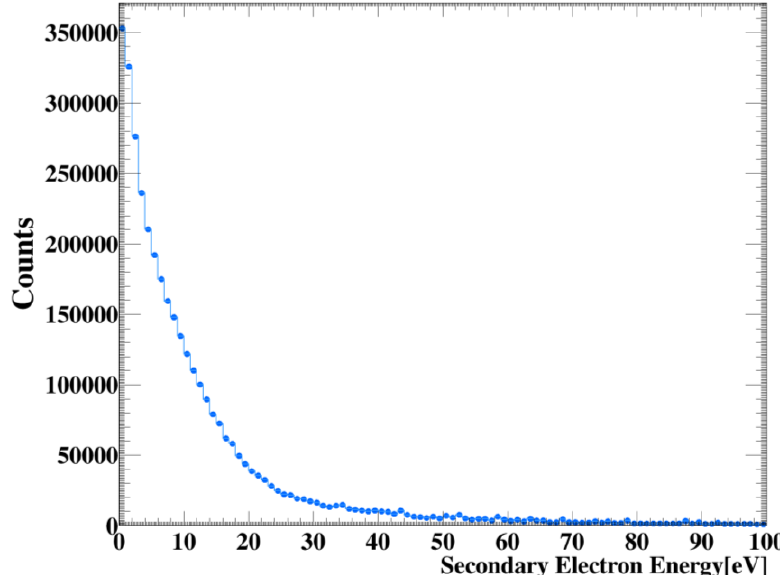
Figure 6. Electron emission spectrum on gold surface as a function of GNP clusters at a concentration of 5 mg/mL.